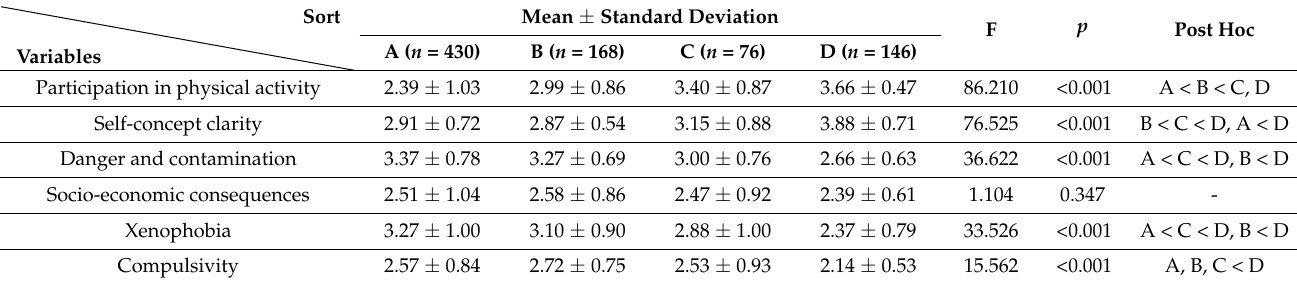
Table 11. Differences in each variable according to the duration of participation in physical activity in months.